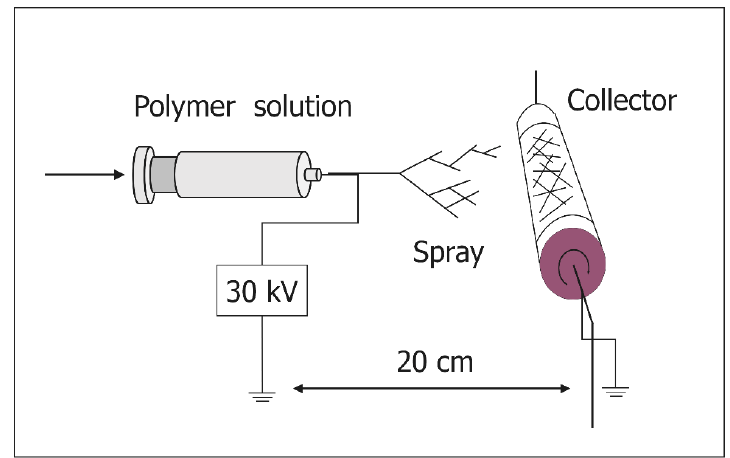
Figure 1. A schematic diagram of the electrospinning system for producing a thin carbon nanofiber web. The polyacrylonitrile solution was ejected from the needle tip under a high electric field and subsequently deposited in a form of web on collector.